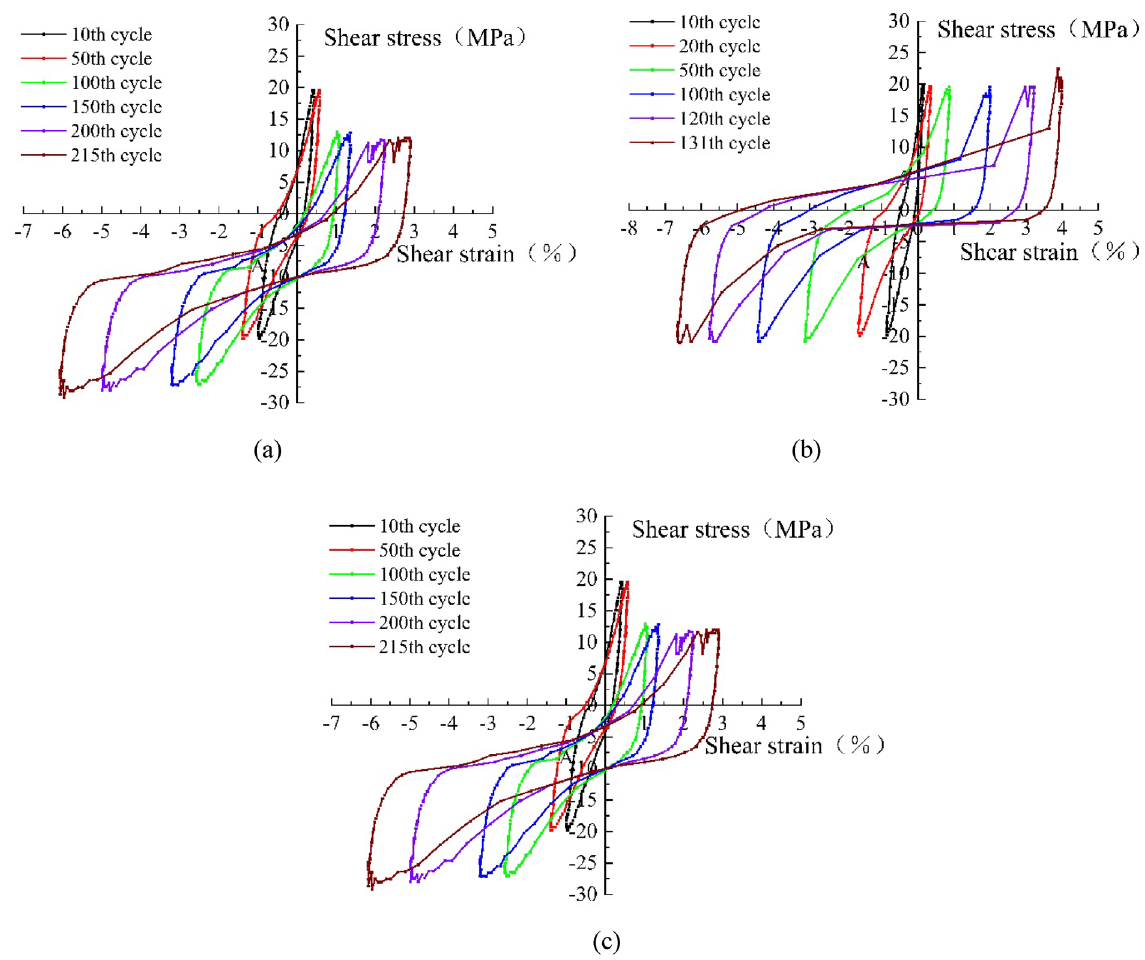
Figure 6. Hysteresis curves of the three different root distribution patterns of soils: ( a ) plain soil hysteresis curve, ( b ) crossed reinforced soil hysteresis curves, and ( c ) mixed reinforced soil hysteresis curves.